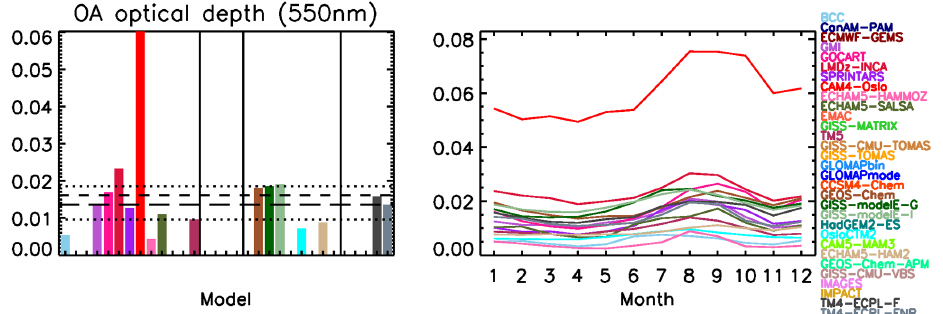
Figure 6. Same as in Fig. 2, for OA all-sky aerosol optical depth at 550nm.